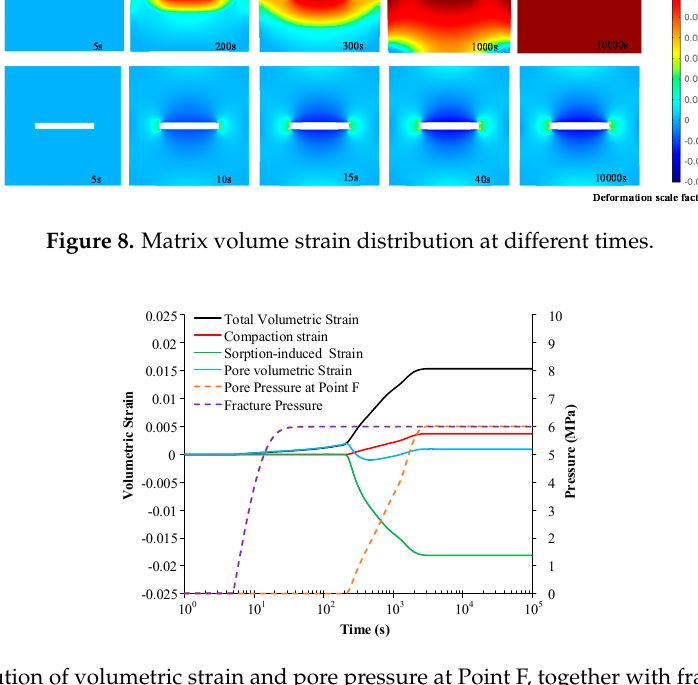
Figure 10. Temporal evolution of matrix permeability ratio. 4.2. Impacts of Fracture Properties Two different treatments of the fracture are used in this section to investigate and compare the impacts of fracture properties on the fracture aperture change. Figure 11 illustrates the evolution of fracture aperture change due to different fracture properties. The Young’s modulus of the fracture is